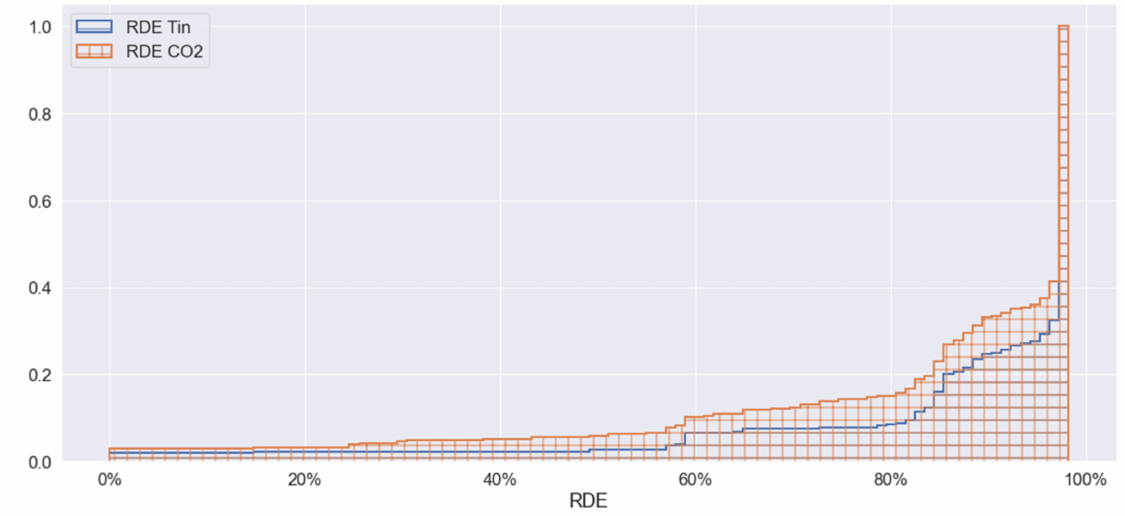
Figure 9. Cumulative RDE for indoor temperature (Tin) and CO